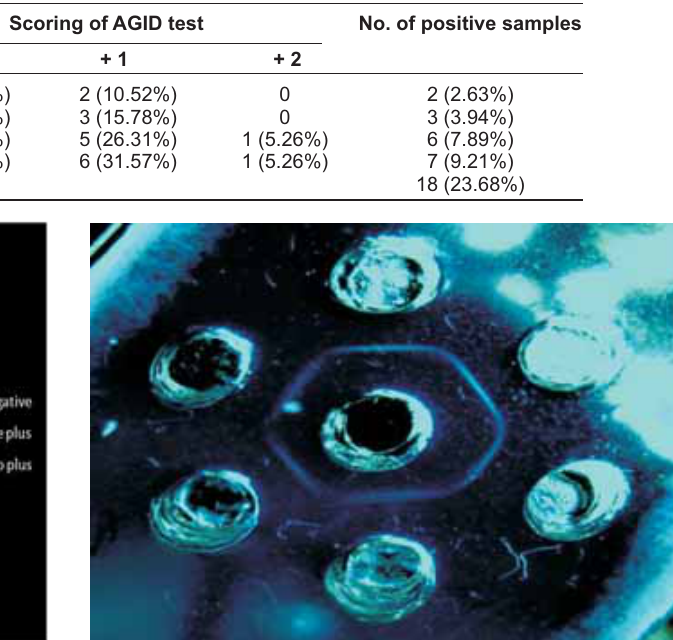
Figure-4: AGID test positive result showing the clear precipitin bands.